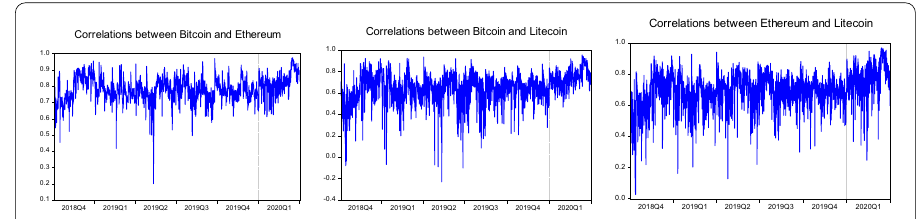
Fig. 3 Time-varying correlations computed from the VAR-BEKK-AGARCH model